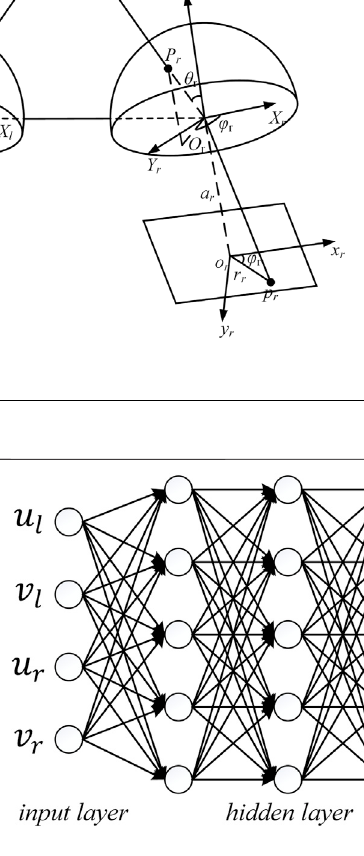
FIGURE 2 | Structure of the